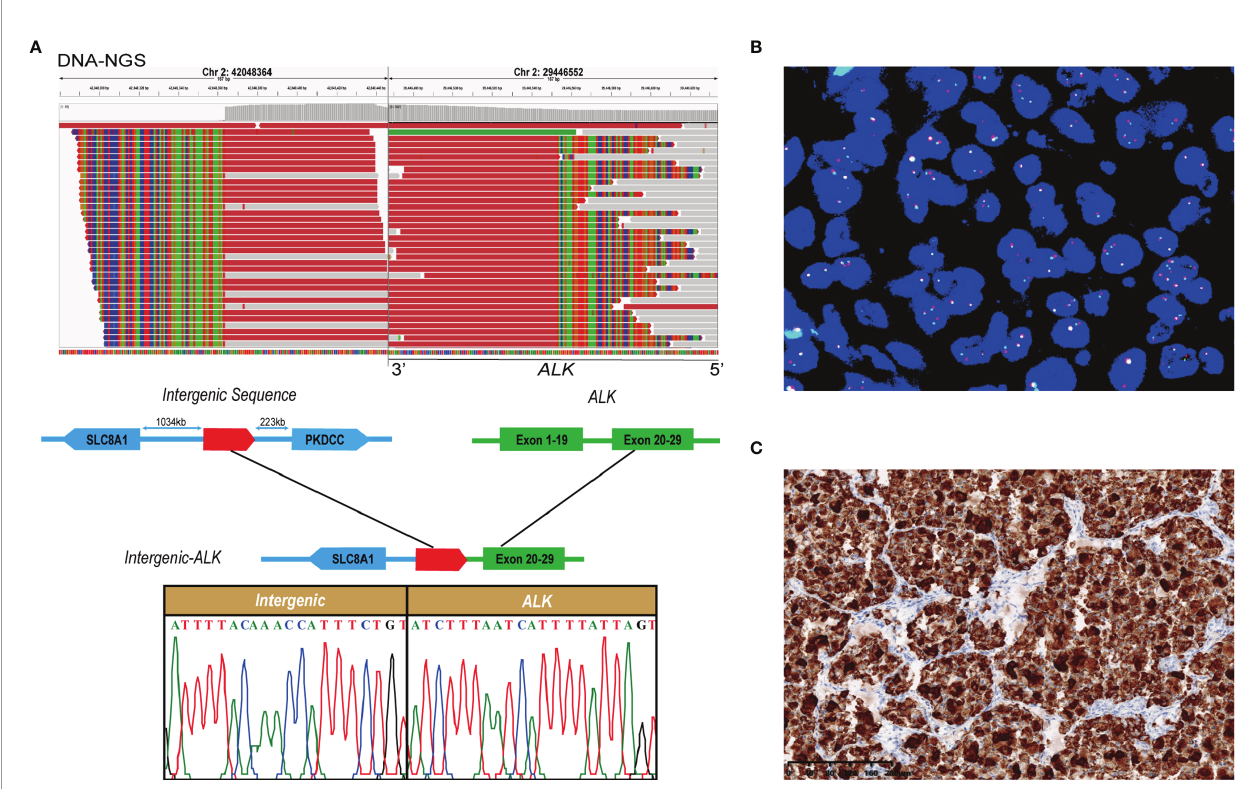
FIGURE 2 | Identi fi cation of a novel intergenic ALK fusion. (A) Sequence analysis of the intergenic-ALK fusion. Upper panel showed reads of fusion on Integrative Genomic Viewer. Lower panel showed a schematic presentation of breakpoints and the Sanger ’ s sequencing result. (B) FISH analysis showed fused yellow signals (negative signal), single green signals (positive signal), and single red signals (positive signal) in the patient ’ s specimen. (C) Immunohistochemical staining with anti- ALK antibody (D5F3) revealed a high level of ALK